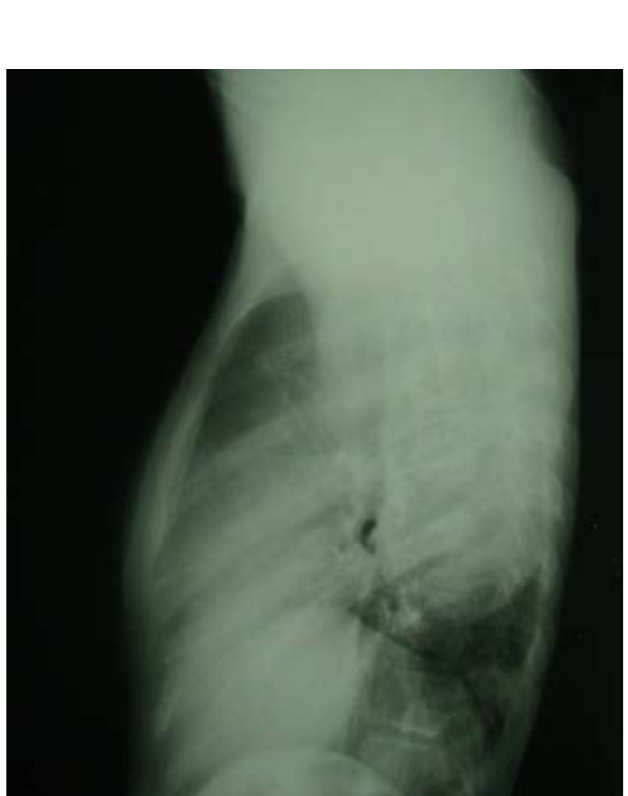
Figs 18a and b. Posteroanterior and lateral X-rays of the chest with sarcoma- tous change in the right posterior mediastinal neurofibroma with rib erosions. Note surgical clips (arrowed) in the neck from previous